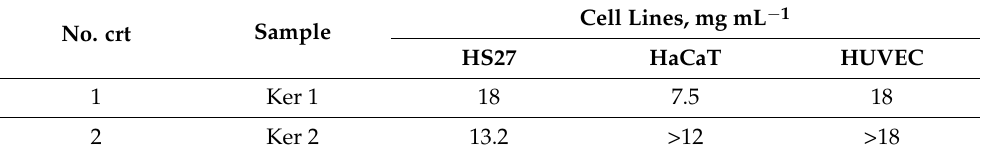
Table 4. The maximum dose allowed for Ker 1 and Ker 2 depending on the cell line